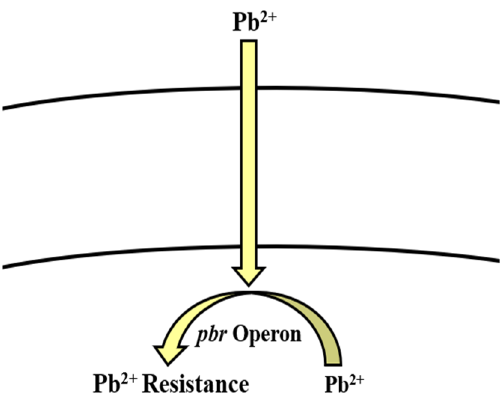
Figure 5. pbr operon involved in the regulation of lead resistance in Bacillus spp.